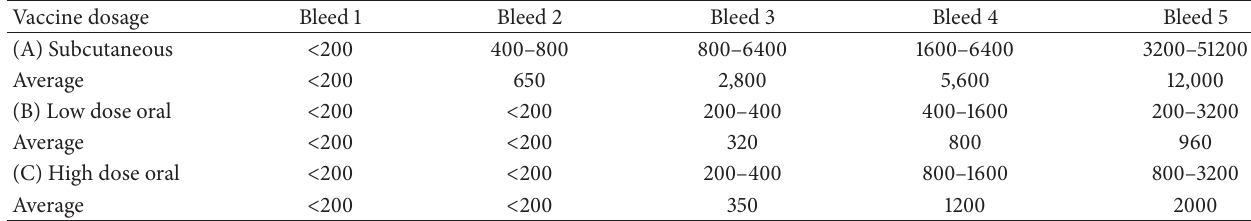
Table 1: Anti-VP1 IgG titers, defined as reciprocals of dilutions giving a response twofold above background. Vaccine dosage